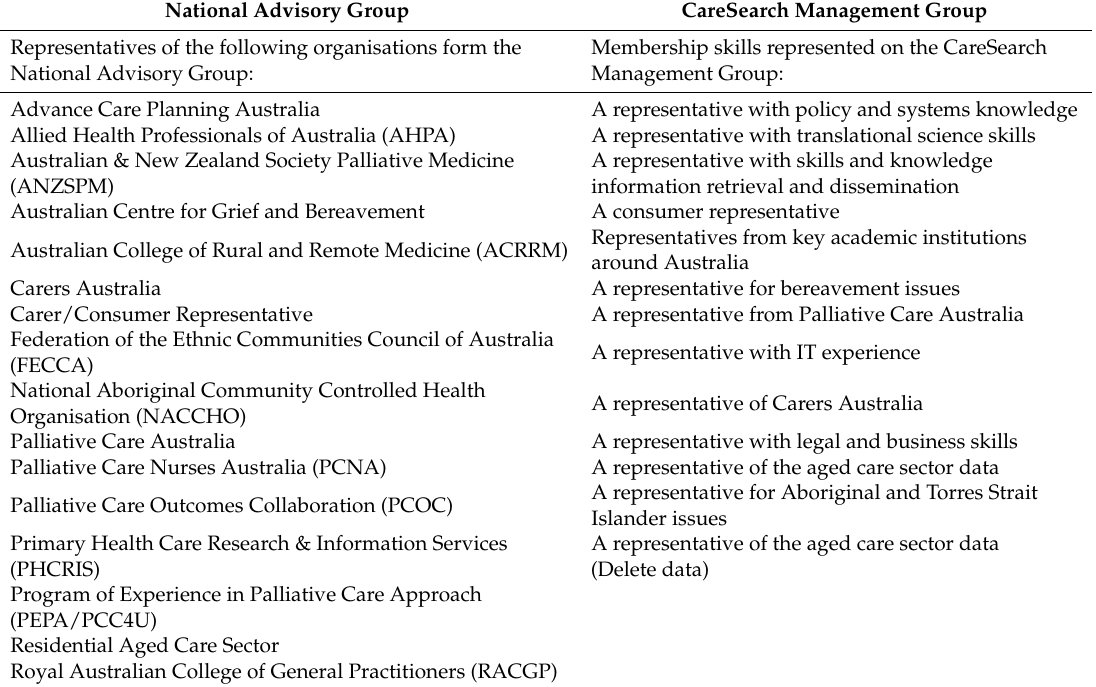
Table 1. Governance bodies: representation